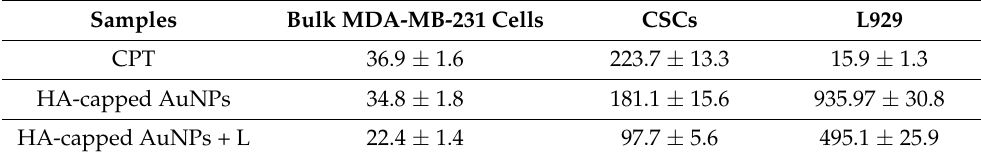
Table 2. IC 50 values ( µ g/mL) of different samples against different types of